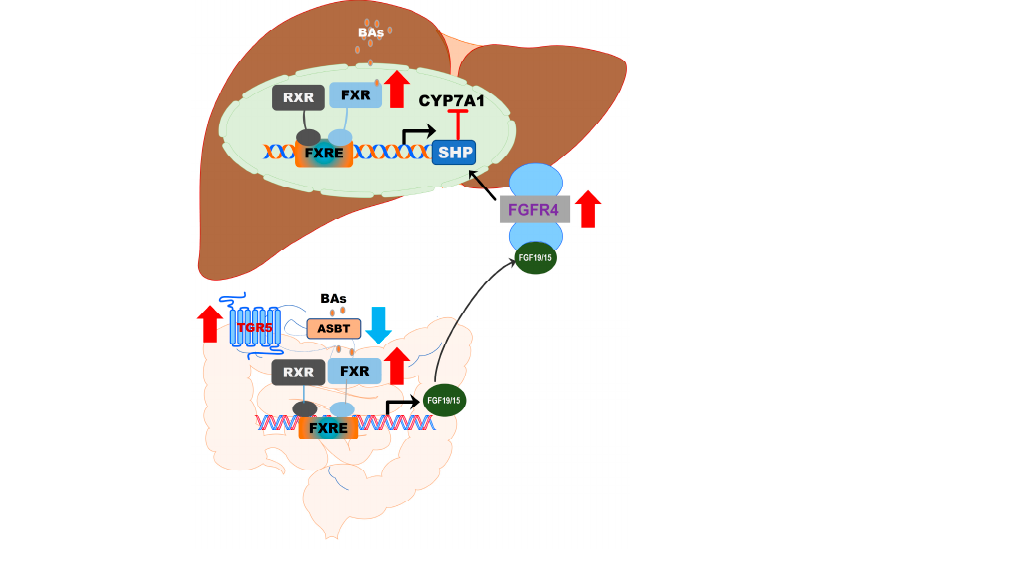
Figure 9. Targeting intrahepatic BA circulation represents promising therapeutics for NASH. Acti- vation of FXR, TGR5, or inhibition of ASBT has beneficial effects on modulating hepatic lipid me- tabolism and inflammatory